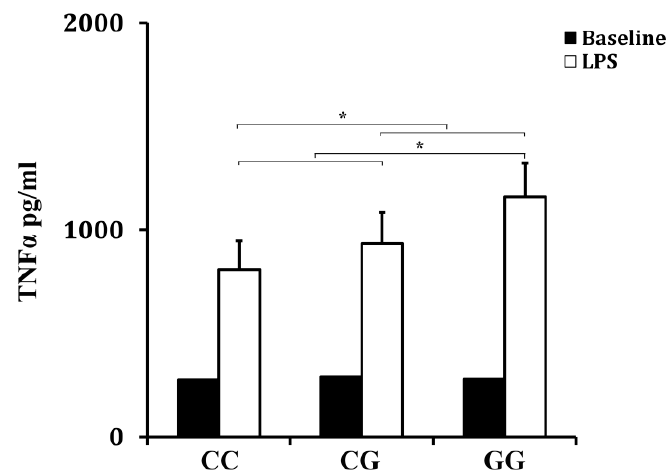
Figure 1. Effect of the PPAR γ rs10865710 polymorphism on LPS-induced TNF α production ( p = 0.041 for the dominant model; p = 0.027 for the recessive model).